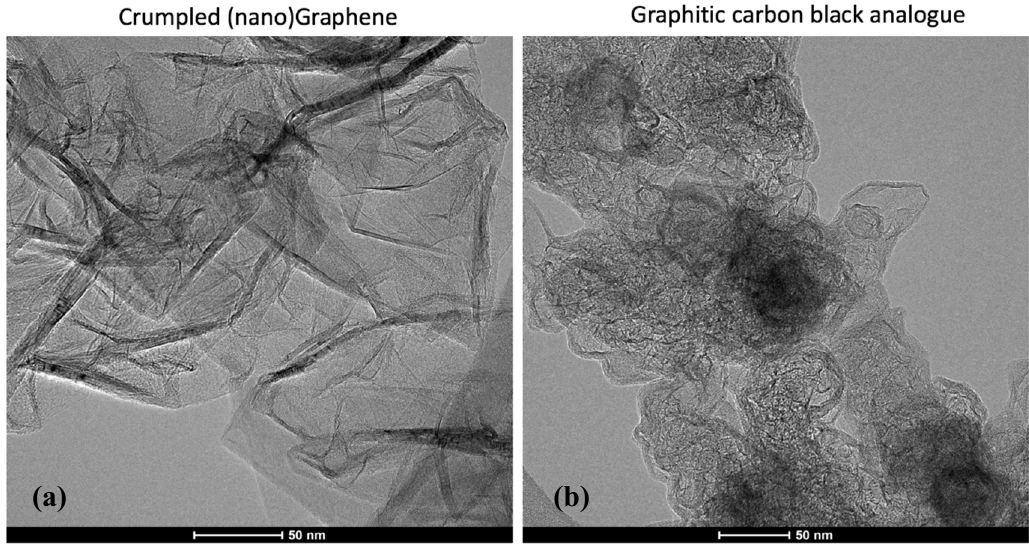
Figure 2. High resolution images of plasma formed ( a ) nanographene and ( b ) GCBA carbon.